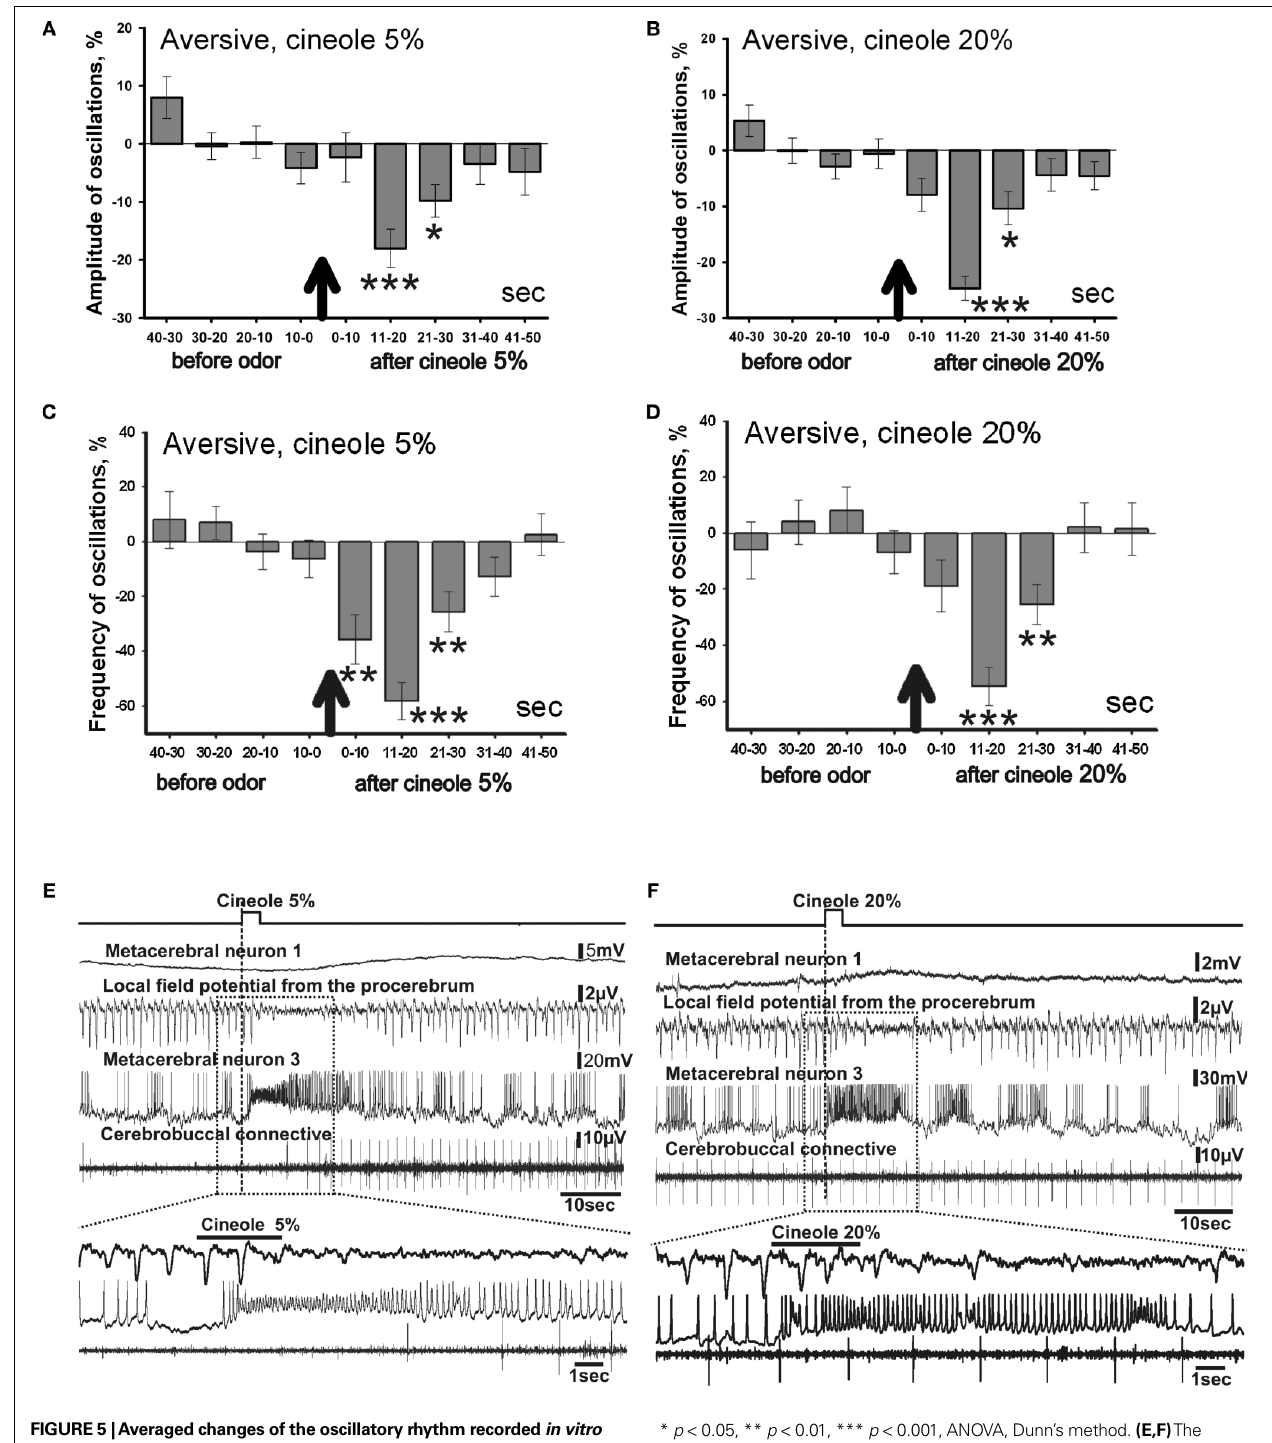
FIGURE 5 | Averaged changes of the oscillatory rhythm recorded in vitro in the procerebrum of snails trained to respond with aversive reaction to odor application. (A) Changes in the amplitude of the procerebral oscillations in response to cineole application in 5% ( n = 6) and (B) 20% ( n = 4) concentrations. (C) Changes in the frequency of the procerebral oscillations in response to cineole application in 5% ( n = 6) and (D) 20% ( n = 4) concentrations. Vertical bars indicate the standard error of the